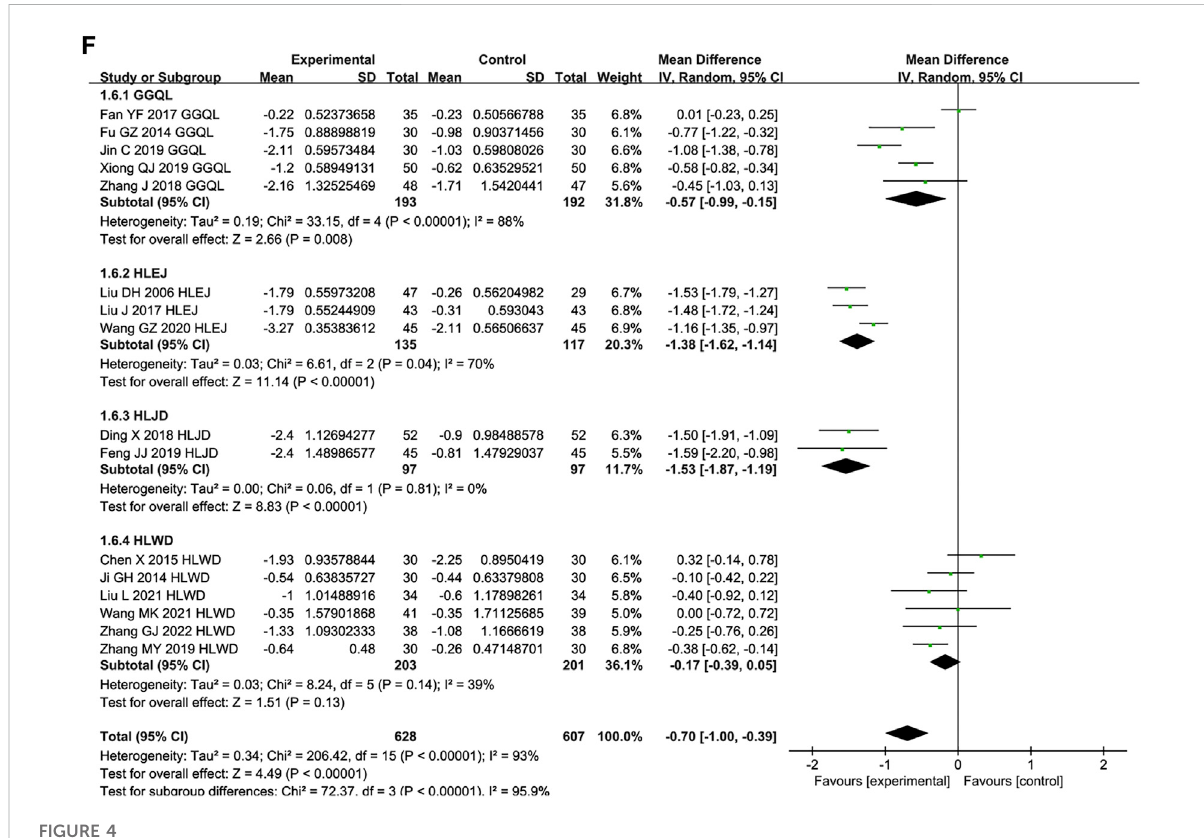
(Figure 4I). Subgroups were divided depending on the type of HLPs for HDL-c. The results revealed that patients who